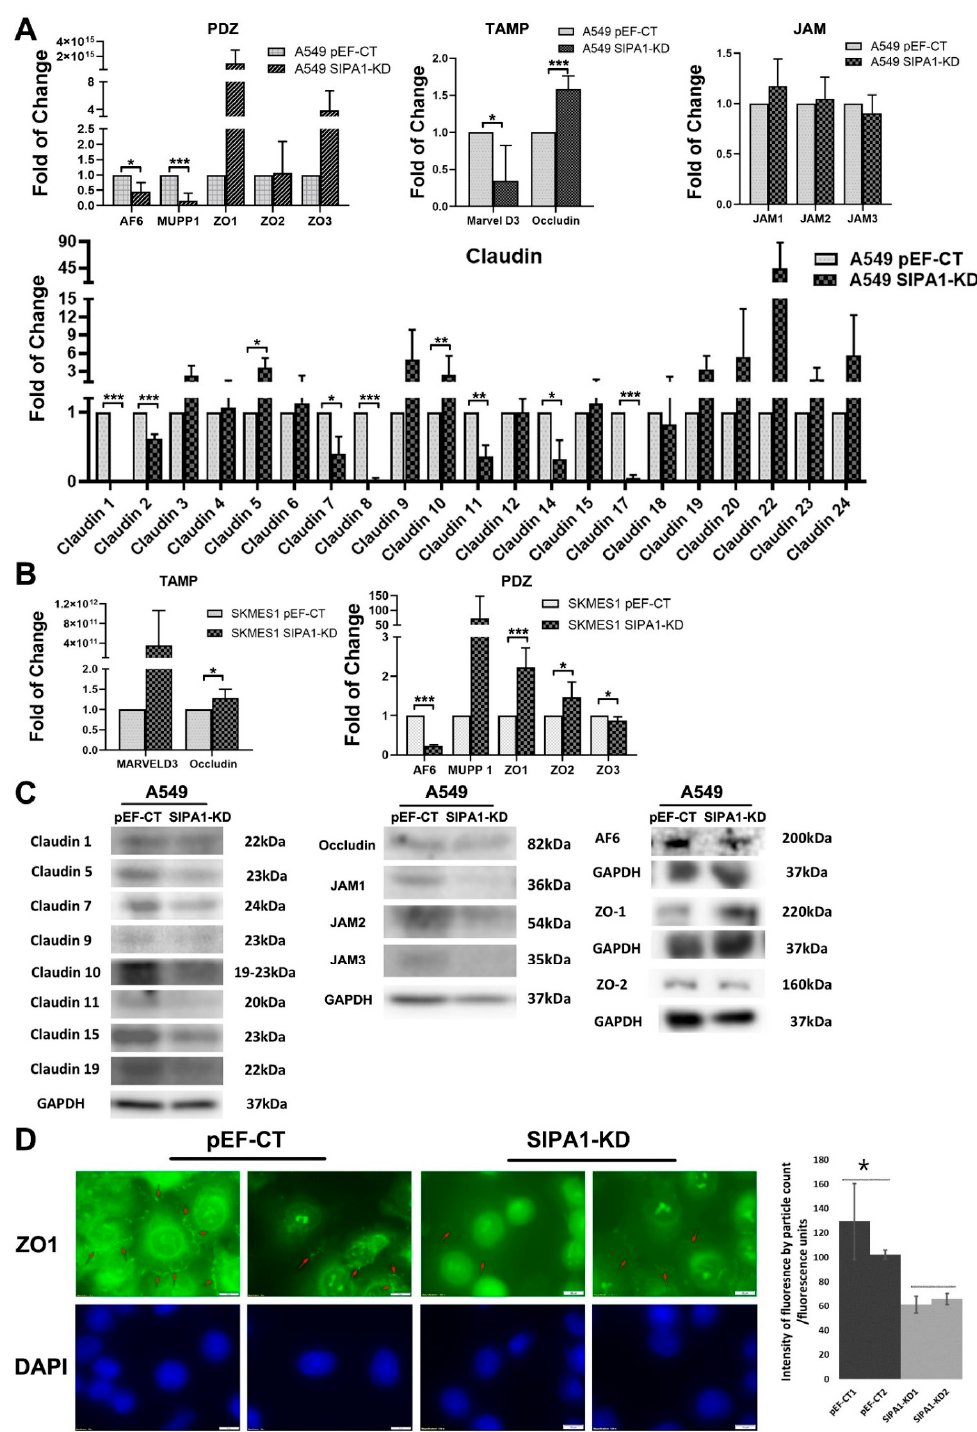
Figure 4. The impact of SIPA1 knockdown on tight junction molecules in lung cancer cells. ( A ) The effect of SIPA1 knockdown on gene expression of PDZ domain containing proteins, TAMP proteins, JAM family, and Claudin family in A549 cells. ( B ) The effect of SIPA1 knockdown on gene expression of TAMP proteins, and TJ proteins containing a PDZ domain in SKMES1 cells. ( C) The effect of SIPA1 knockdown on expression of Claudin family, Occludin, JAM family, and PDZ domain containing proteins in A549 cell line. ( D ) Immunofluorescence staining for ZO1 in A549 pEF-CT cells and SIPA1-KD cells, accompanying graph shows significant difference between expression levels of ZO1 in pEF-CT cells (image 1and 2) versus SIPA1-KD (1 and 2). Experiments were repeated n = 3. *, **, *** indicate statistical